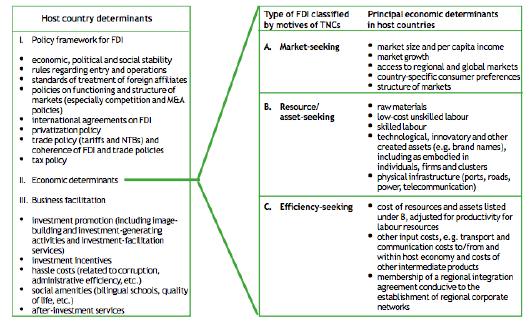
Figure 1. Host Country Determinants of FDI Source: World Investment Report 1998: Trends and Determinants, Table IV,